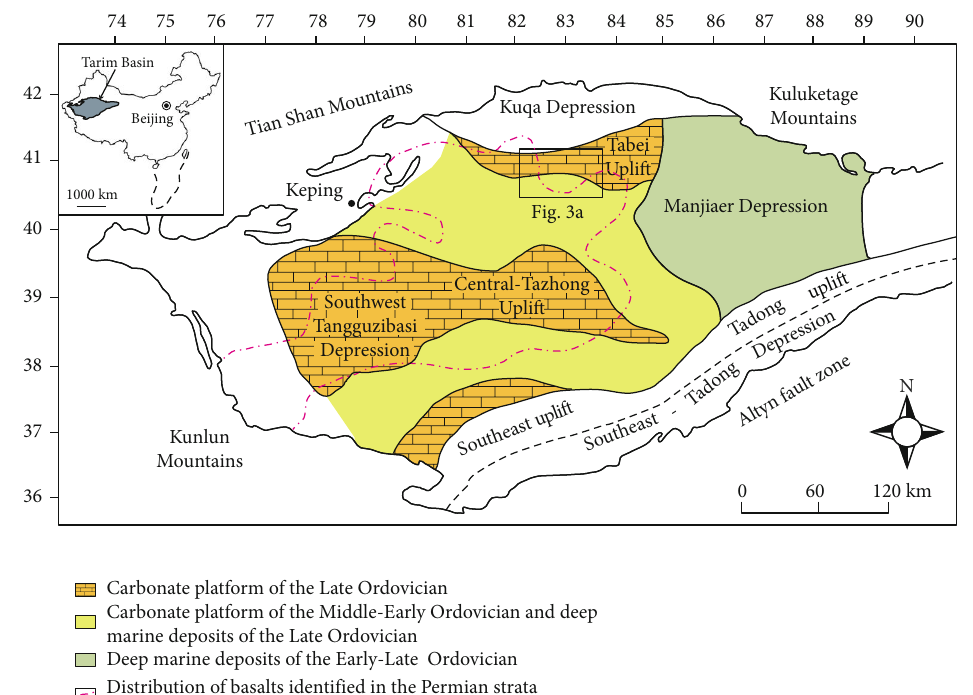
Figure 1: Simpli fi ed tectonic map of the Tarim Basin showing paleouplifts and depressions (after Zhao et al. [25]), the distribution of platform margins of Ordovician carbonates (after Lin et al. [59]), and occurrence of basalts of the Tarim Large Igneous Province (after Xu et al.